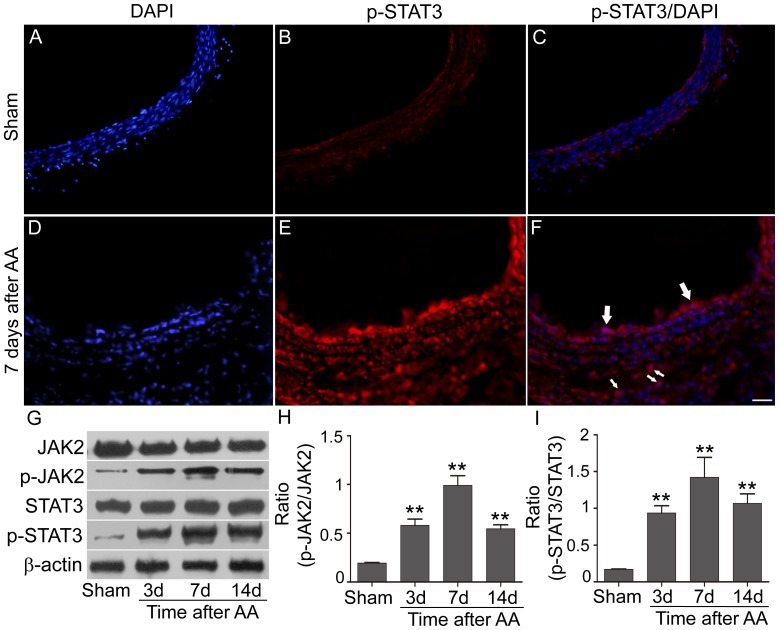
activation features of JAK2/STAT3 in the vessel wall after AA.
A–F: p-STAT3 positive cells (red) in Sham group and AA group determined by immunofluorecence (Samples: 7 days after AA; Arrows indicated the typical positive cells. n = 3 anastomoses. Bar = 100 µm). G–I: Representative bands of target proteins in Sham group and AA groups at 3, 7, and 14 days after surgery (n = 4 anastomoses). The analysis showed the expression p-JAK2 and p-STAT3 increased and peaked at 7 days after the AA procedure (** p<0.01 versus Sham group).